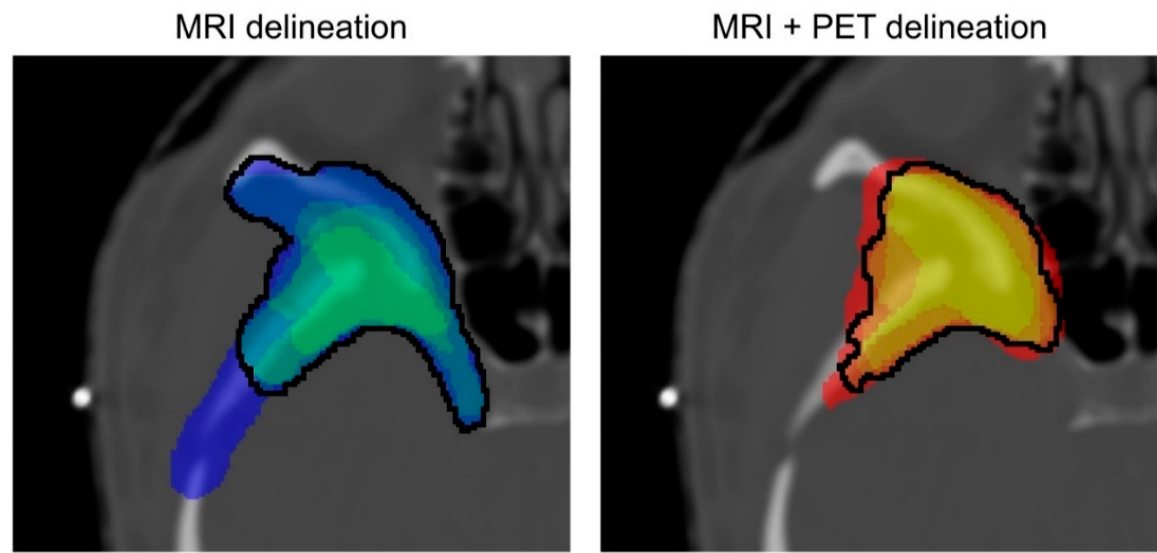
Figure 1. Example of the different possible consensus definitions given for the MRI and MRI + PET delineations. The color coding differentiates the amount of consensus between the physicians. The black curves outline the contours, which were created by using the STAPLE algorithm. For the MRI + PET delineation, the differences between the consensus delineations are smaller compared to the delineations based solely on the MR images.